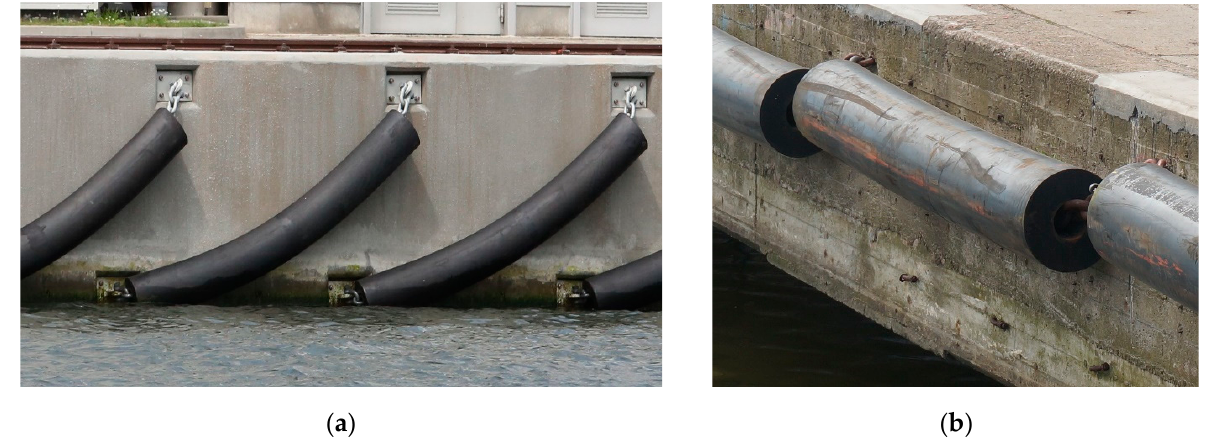
Figure 1. Cylindrical fenders and examples of their mounting on the quay. ( a ) Cylindrical oblique fenders; ( b ) Horizontally mounted cylindrical fenders.